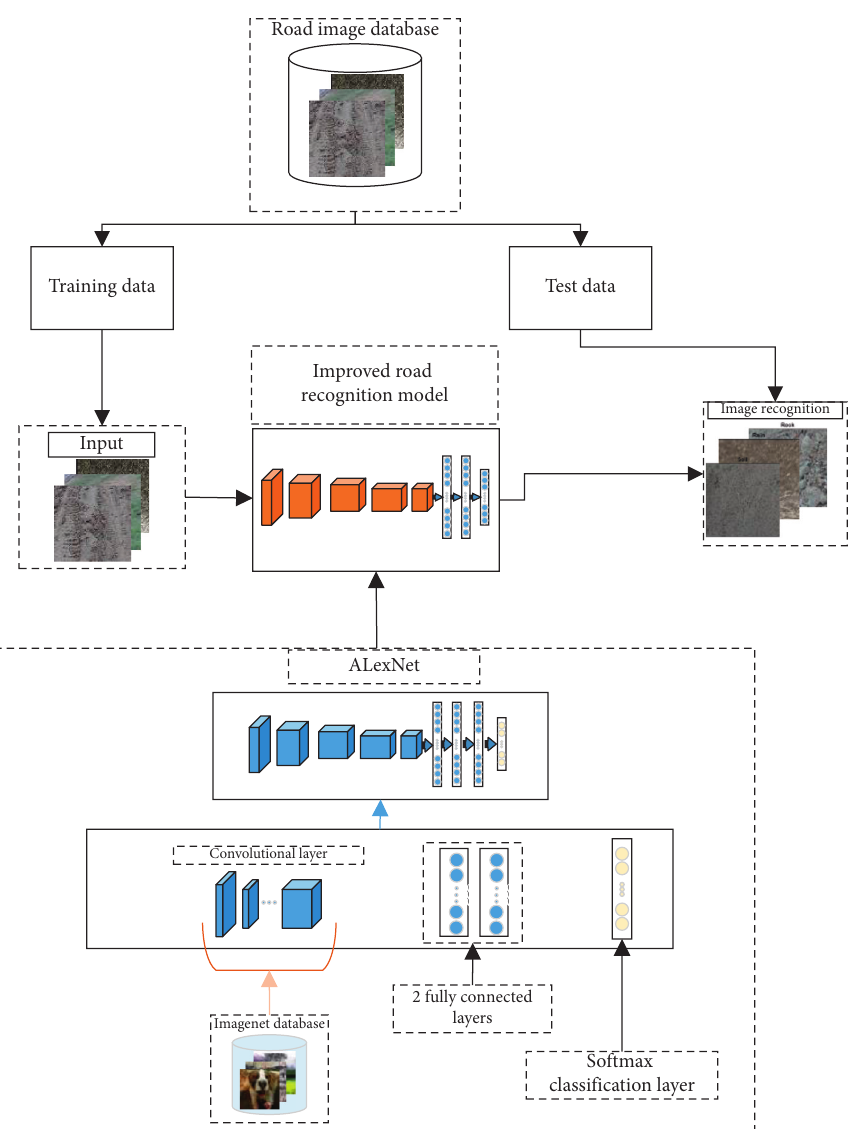
Figure 5: Structure of the road surface recognition model.